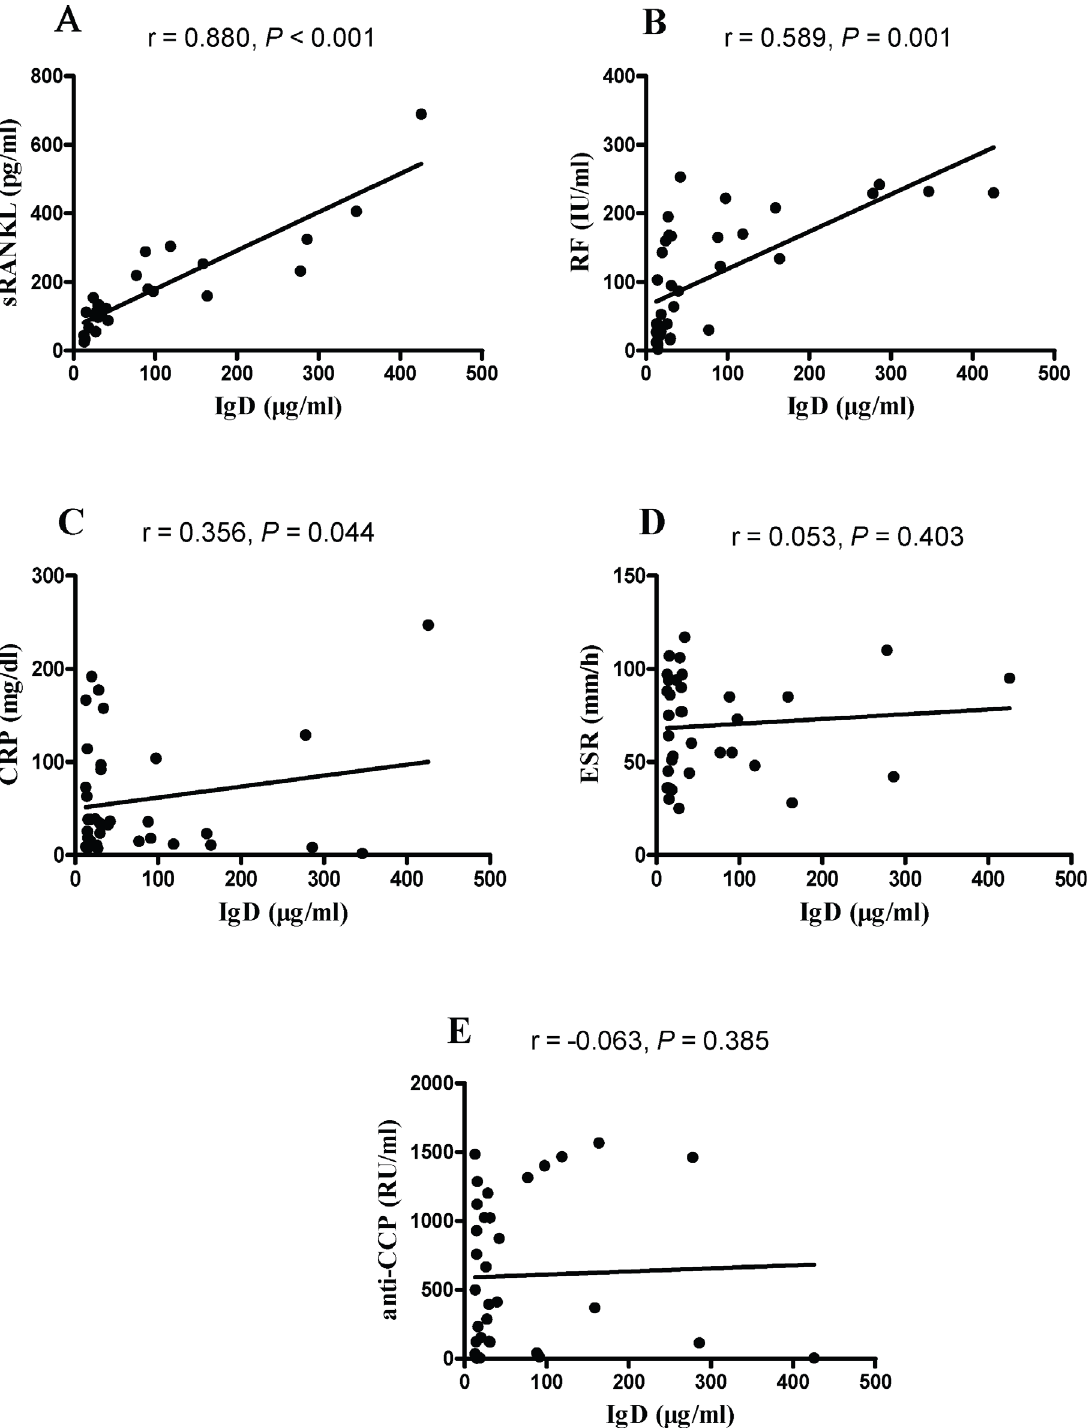
Fig 2. The correlation of the serum IgD levels with biomarkers in RA patients. Pearson correlation analyses were shown for the association of IgD with sRANKL (A), RF (B), CRP (C), ESR (D) and anti-CCP (E).